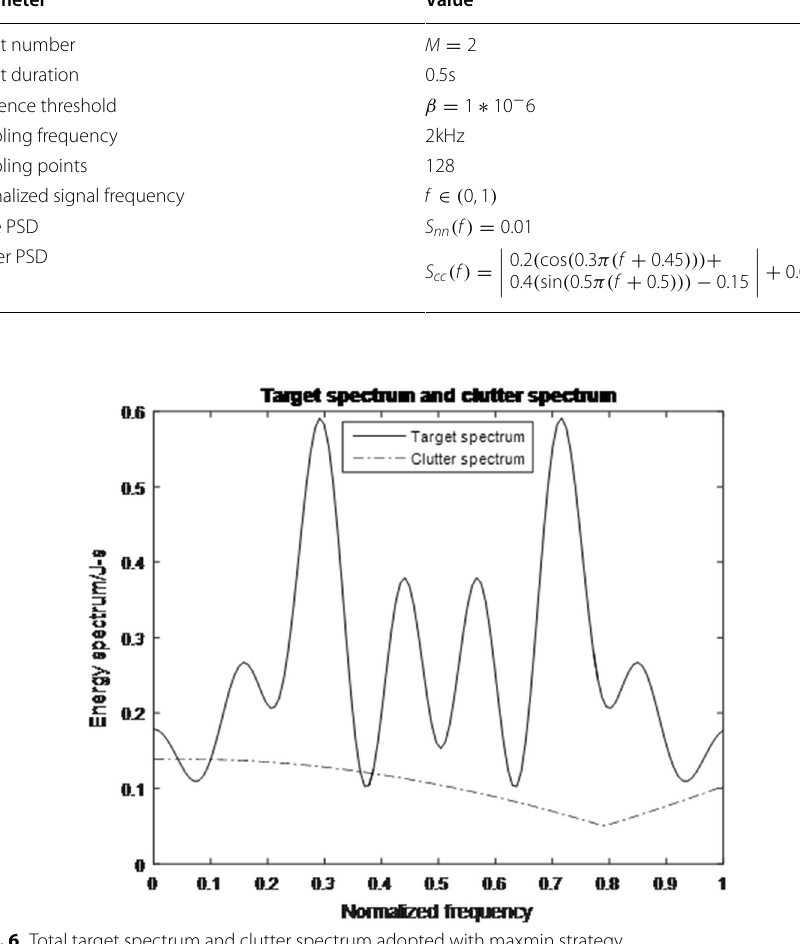
Fig. 6. The power spectrum of jamming waveform is shown in Fig. 7, it includes the max- imum SINR-based waveform and the improved maximum SINR-based waveform, and the SINR-based waveform is a compared waveform [48].